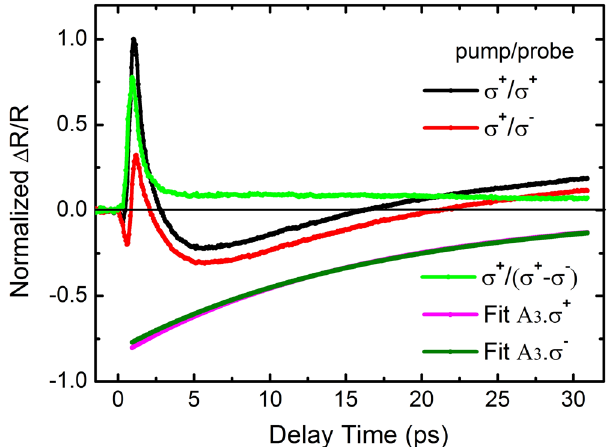
Figure 5. Polarization-resolved transient reflectivity of trions by σ + - or σ − -polarized probes (SCP or OCP) under σ + -polarized pumping. All the data are normalized relative to the peak value of SCP signal. The pump energy is set at 1.67 eV, and the probe energy is set on-resonant with trions. The green trace shows the intervalley decay dynamics by calculating the difference between the SCP and OCP signals. The negative decay components for both the SCP and OCP signals are extracted by fitting and marked with A 3 · σ + (Magenta trace) and A 3 · σ − (Olive trace),